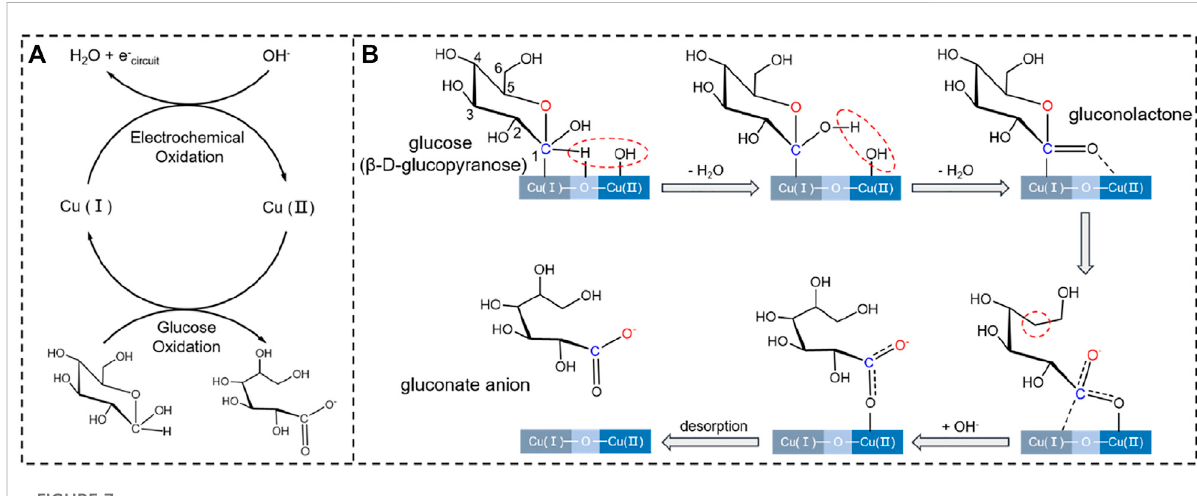
FIGURE 7 (A) SchematicfortheredoxcyclesofCu + /Cu 2+ andglucose/gluconateinthepresenceofOH. (B) PossibleintermediatesformedduringGORon